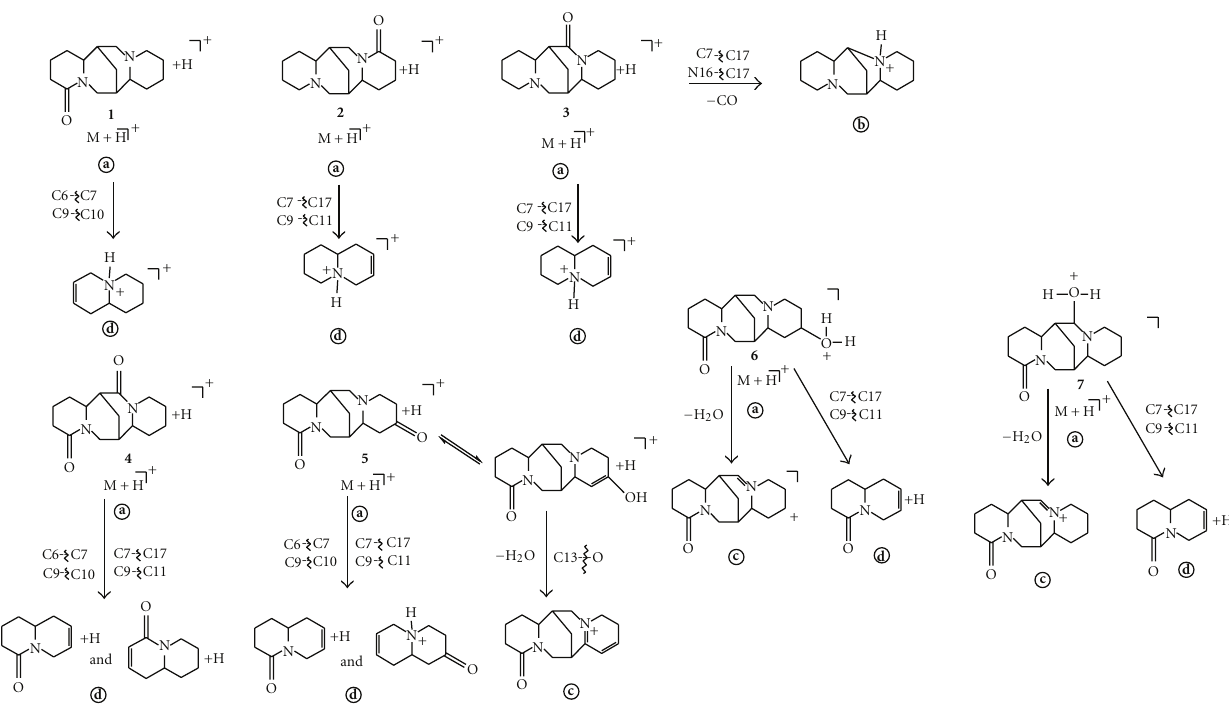
Scheme 1: The fragmentation pathways in the FAB spectra of 1 – 7 .